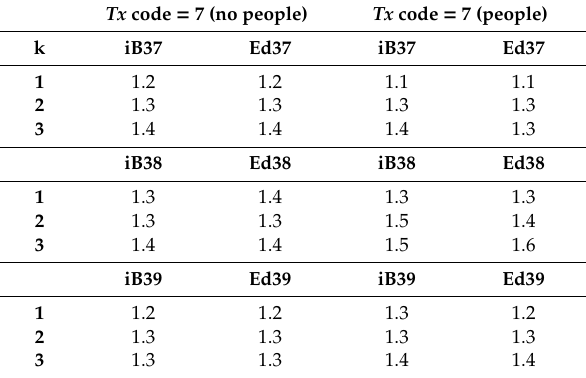
Table 19. Comparison of accuracies (in m) for Tests #6a and #6b. For each option, the first and second data columns refer to the iBeacon and Eddystone protocol respectively. The three advertising channels are symbolized as Ch 37, etc. and the number of neighbors in the WKNN algorithm as k . Tx code = 7 (no